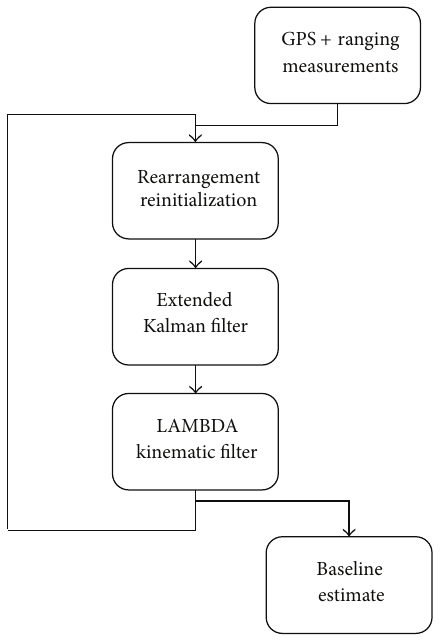
Figure 1: Block diagram of the CDGPS-only filtering scheme [4, 7, 20].